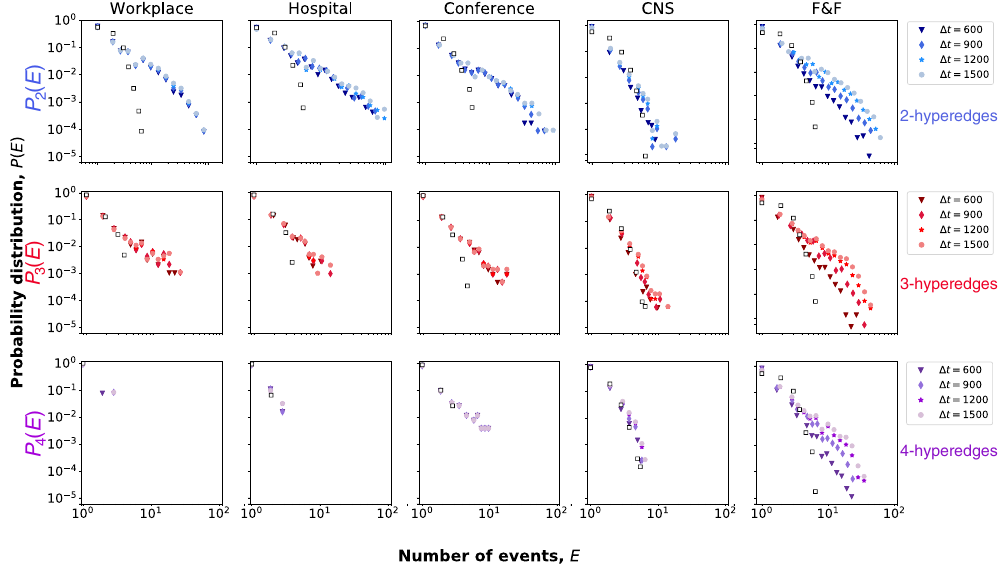
Figure 3. Higher-order structures of temporal trains. Number of events distribution P ( E ) for group interactions of fixed size: size 2 (first line), size 3 (second line) and size 4 (third line) interactions. Symbols and colors represent different values of the aggregation window (cid:31) t . Empirical results (full symbols) are compared to the null models obtained by shuffling the event times (empty squares, distributions obtained aggregating with (cid:31) t = 600